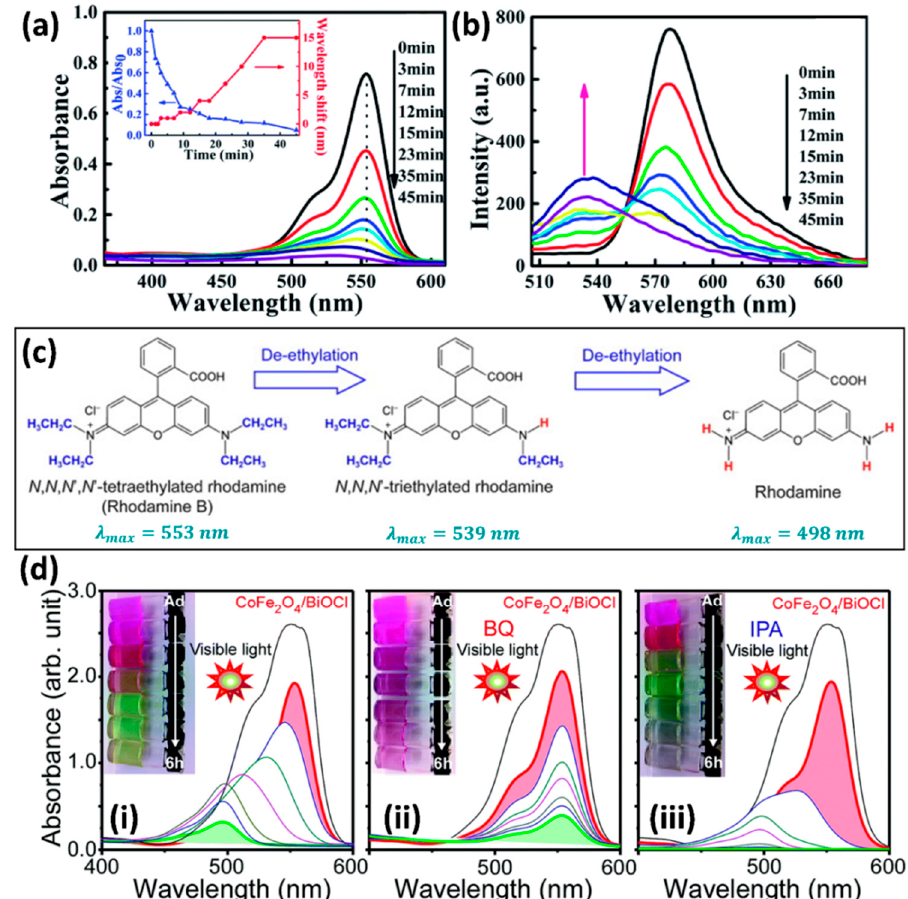
Figure 1. Photodegradation of RhB over Ag 3 PO 4 nanoparticles under visible illumination recorded as ( a ) ultraviolet–visible light (UV–Vis) absorption spectra (inset shows the correlation between absorbance changes of maxima absorption peak (blue line) and the corresponding wavelength shifts (red curve)), and ( b ) steady-state PL spectra. (reproduced with permission from [31] . Copyright Royal Society of Chemistry, 2017.) ( c ) Scheme of the de-ethylation process of RhB molecules. ( d ) Photodegradation of RhB over CoFe 2 O 4 /BiOCl microflowers under visible irradiation ( i ) without and with scavengers of ( ii ) BQ and ( iii ) IPA. (inset shows photographs of color change of dye molecules with photodegradation time; reproduced with permission from [34] . Copyright Royal Society of Chemistry, 2015.)